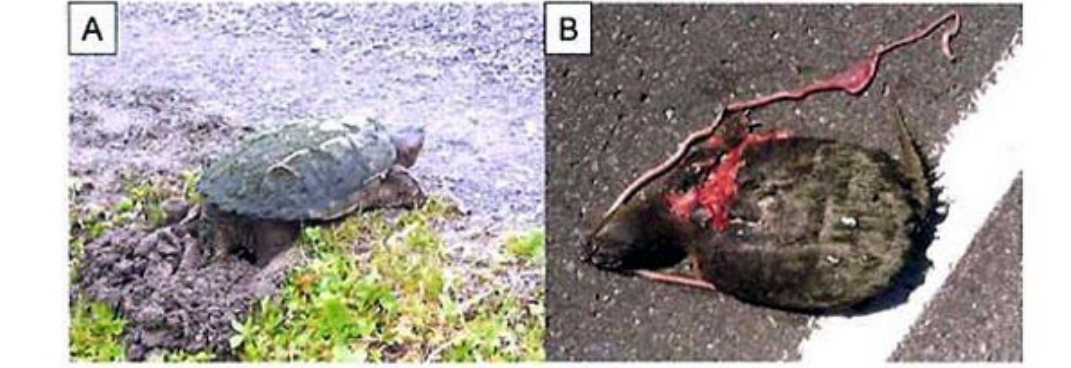
Fig. 1. A. Snapping turtle ( Chelydra serpentina ) digging a nest on the shoulder of a paved road. B. Snapping turtle killed by traffic on the same road. (Photos courtesy of Ewen